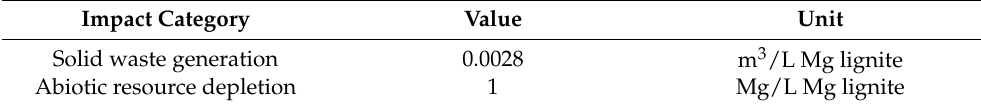
Table 6. The results for solid waste generation and abiotic resource depletion impact